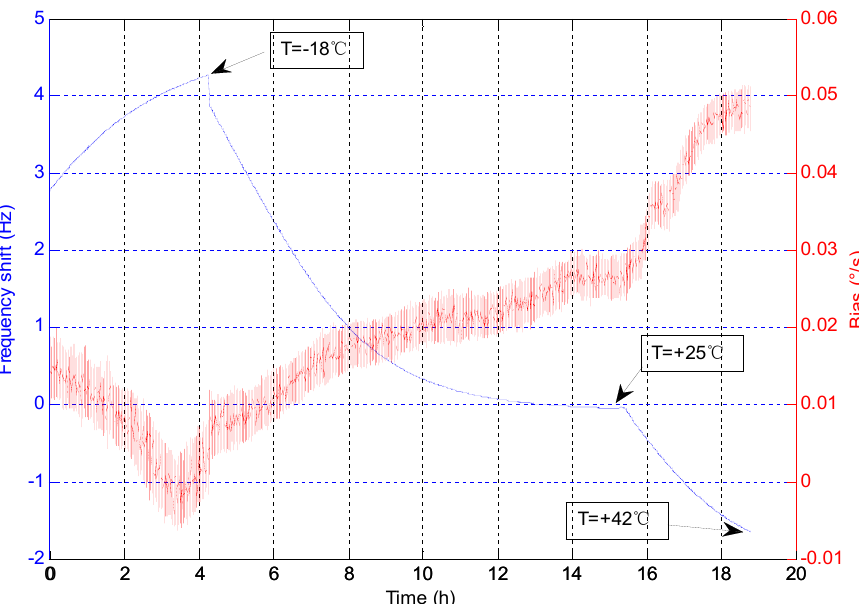
Figure 3. Measured bias drift vs. frequency shift.